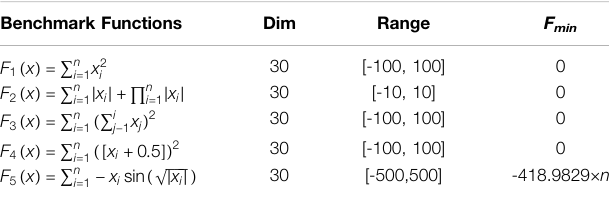
TABLE 1 | Benchmark test functions. Benchmark Functions